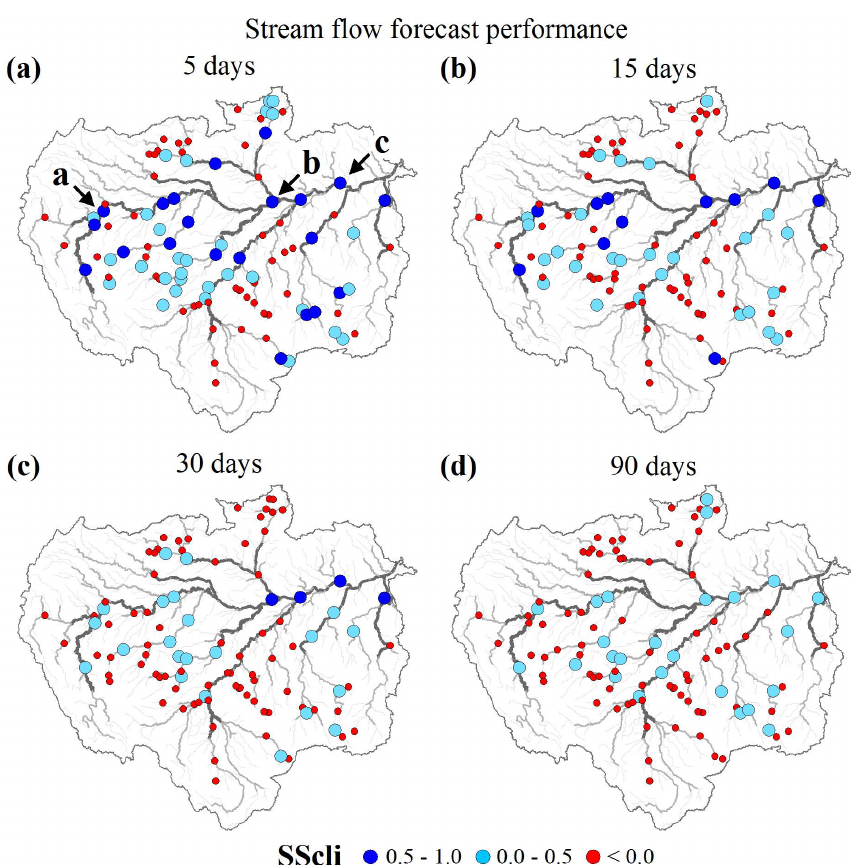
Fig. 9. Evaluation of streamflow forecasts. Spatial distribution of the skill score SS cli for (a) 5, (b) 15, (c) 30 and (d) 90 days lead time.